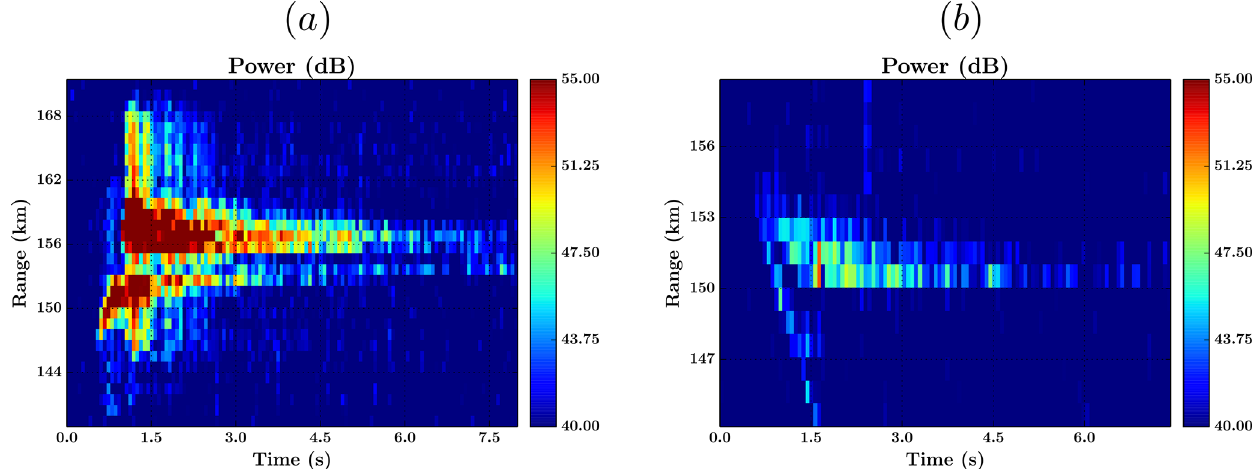
Figure 7. Meteor trails observed with the VHF radar operated in Salinas, Puerto Rico, during the Coqui-II campaign. Panel (a) exhibits absence of backscattering power between the 154 and 155km range that resembles our simulation results shown in Fig. 5, while panel (b) shows that backscattering signals have a sudden decrease in ranges below 150km.